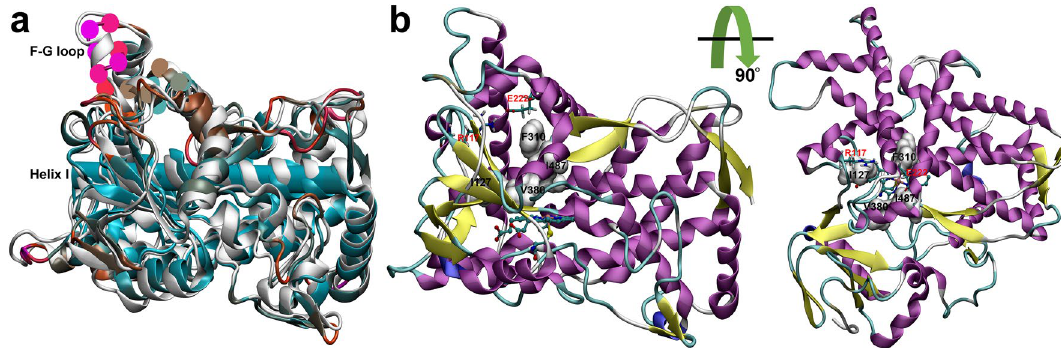
Figure 2. ( a ) Structural superimposition of initial (white color) and the representative conformations of CYP2J2. The helix I composed of residues 297–330 was also shown in Cartoon representation. The mobile F-G loop formed by residues 224–240 was highlighted by spheres. The flexibility increased from the cyan region (inflexible) to the orange and magenta regions (most flexible). ( b ) Representative conformation of CYP2J2 in side and top views, obtained from the 500-ns MD simulations of ligand-free CYP2J2. The key residues Ile127, Phe310, Ala311, Val380, and Ile487 were shown in white spheres (hydrophobic residues). The heme